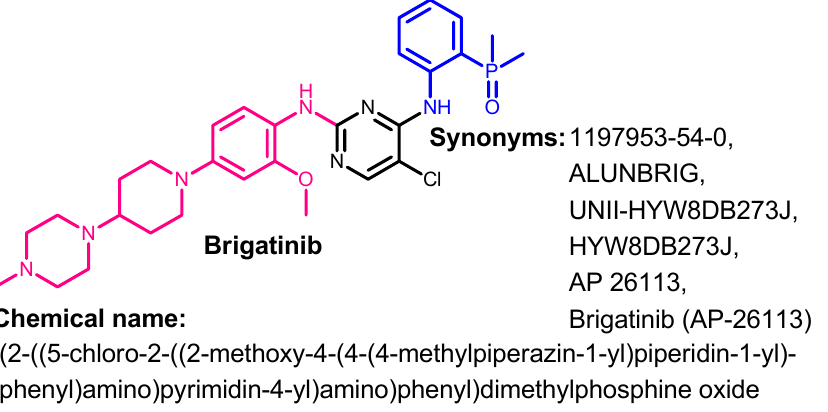
Figure 16. Chemical structure/name/synonyms of brigatinib.